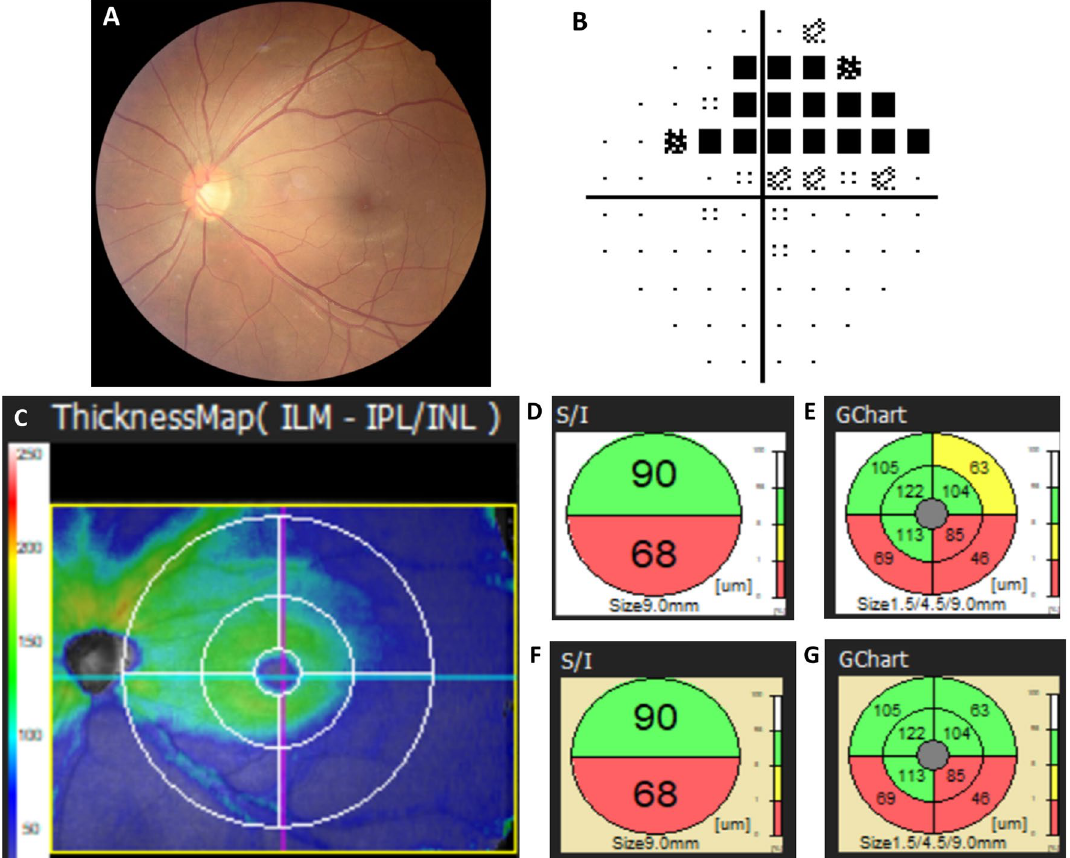
Figure 2. Fundus photography, automated visual fields, and spectral-domain optical coherence tomography images of a 56-year-old highly myopic male diagnosed with glaucoma. The AL of the eye is 26.17 mm, and the refractive error (spherical equivalent) is − 8.0 D. ( A ) Color fundus photograph showing an inferotemporal retinal nerve fiber layer defect. ( B ) Pattern deviation of the Humphrey perimeter showing a